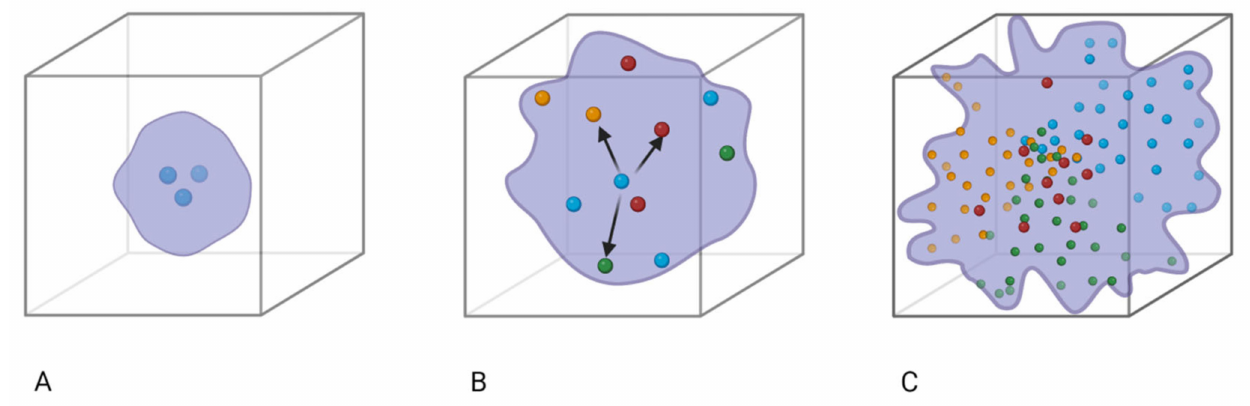
Figure 2. ( A ) Model depicting wild-type virion with allelic differences. ( B ) Model showing a mutation in the wild-type virion (yellow, red, and green). ( C ) Model showing the quasispecies cloud and selection of a particular strain over other strains due to biological constraints.